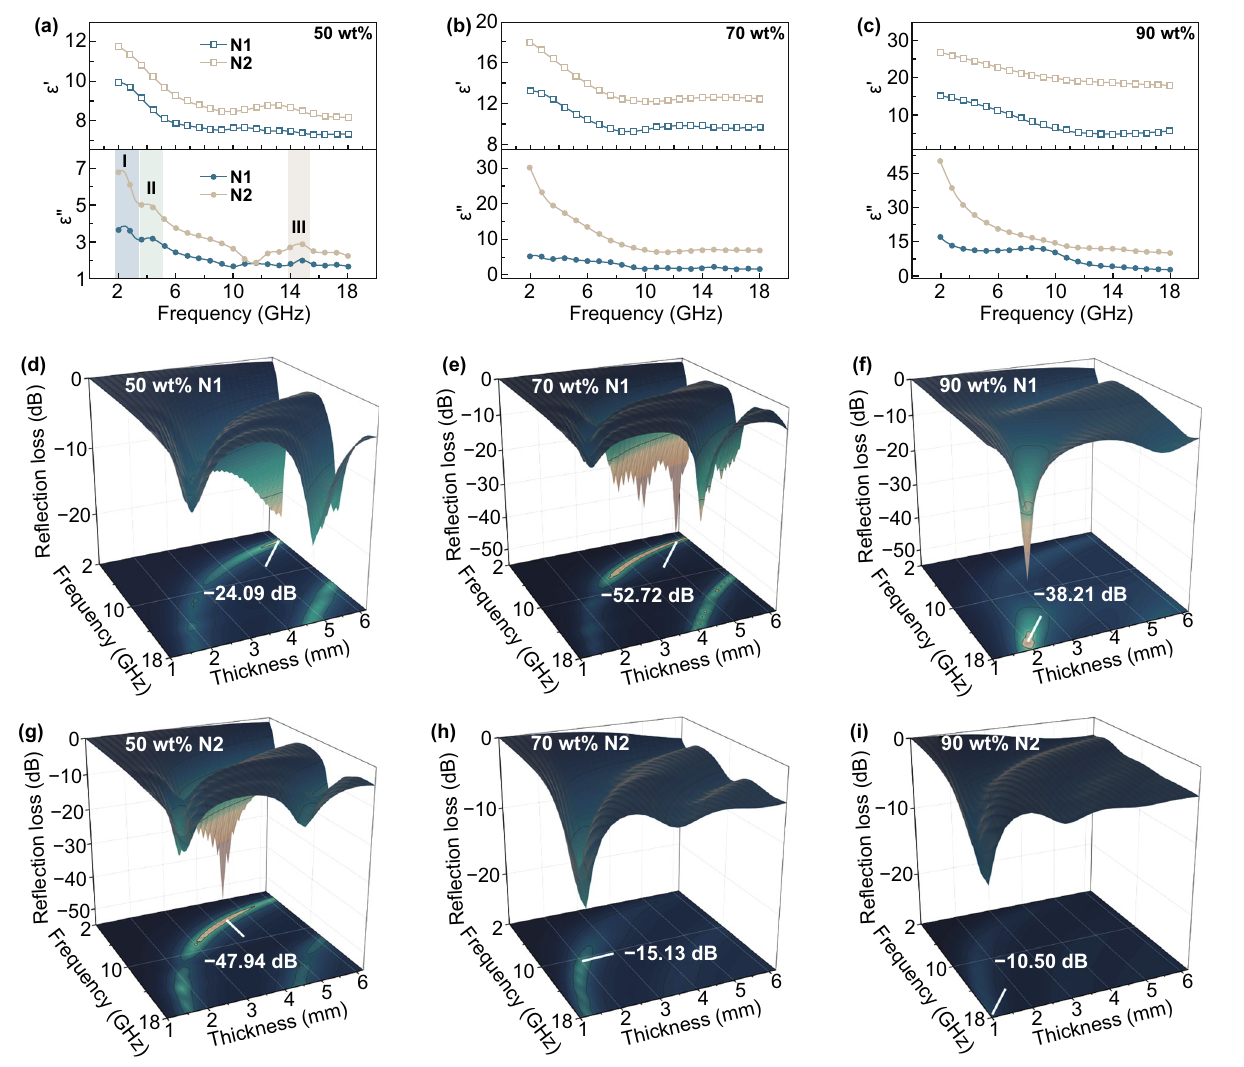
Fig. 3 a–c ε ′ and ε ′′ of N1 and N2 composites with different loading concentrations of 50 wt%, 70 wt%, and 90 wt%. d–f RL of N1 with differ‑ ent loading concentrations. g–i RL of N2 with different loading